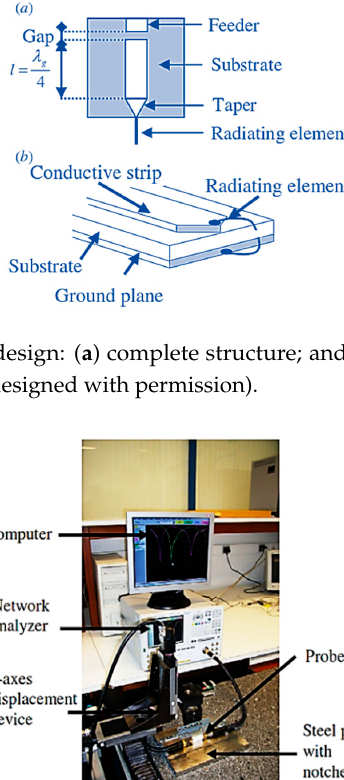
Figure 4. Schematic drawing of the electric dipole probe above a notch. W , h and L represent the width, depth and length of the notch, respectively. d is the probe ‐ to ‐ metal distance (from [29]; copyright © 2008; redesigned with permission). Figure 5. Measured reflection parameter S 11 versus frequency above faultless metal and above a 200 ‐μ m ‐ wide notch for a probe ‐ to ‐ metal distance d = 50 μ m (from [29]; copyright © 2008; redesigned with permission).